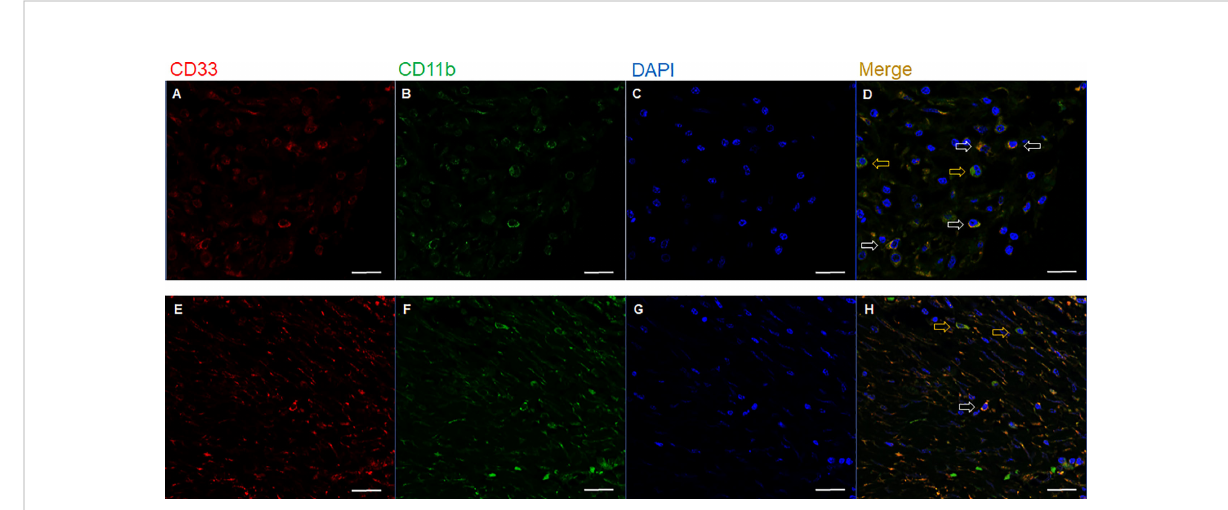
FIGURE 1 Representative immuno fl uorescence images of two cases with (A − D) high (upper row) and (E − H) low (lower row) number of tumor-in fi ltrating MDSCs. Based on the expression of (A, E) CD33, (B, F) CD11b, and (C, G) DAPI, (D, H) the merged triple immuno fl uorescence results were assessed. Cells with yellow color were merged from red and green. yellow arrows: CD11b + CD33 - cells; white arrows: CD11b + CD33 + cells; Scale bar: 20 m m. MDSC, myeloid-derived suppressor cell; DAPI,